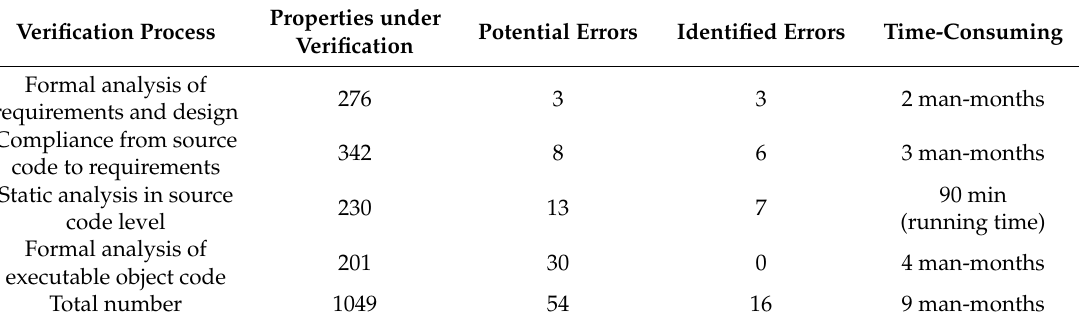
Table 2. Formal verification results of the ADC